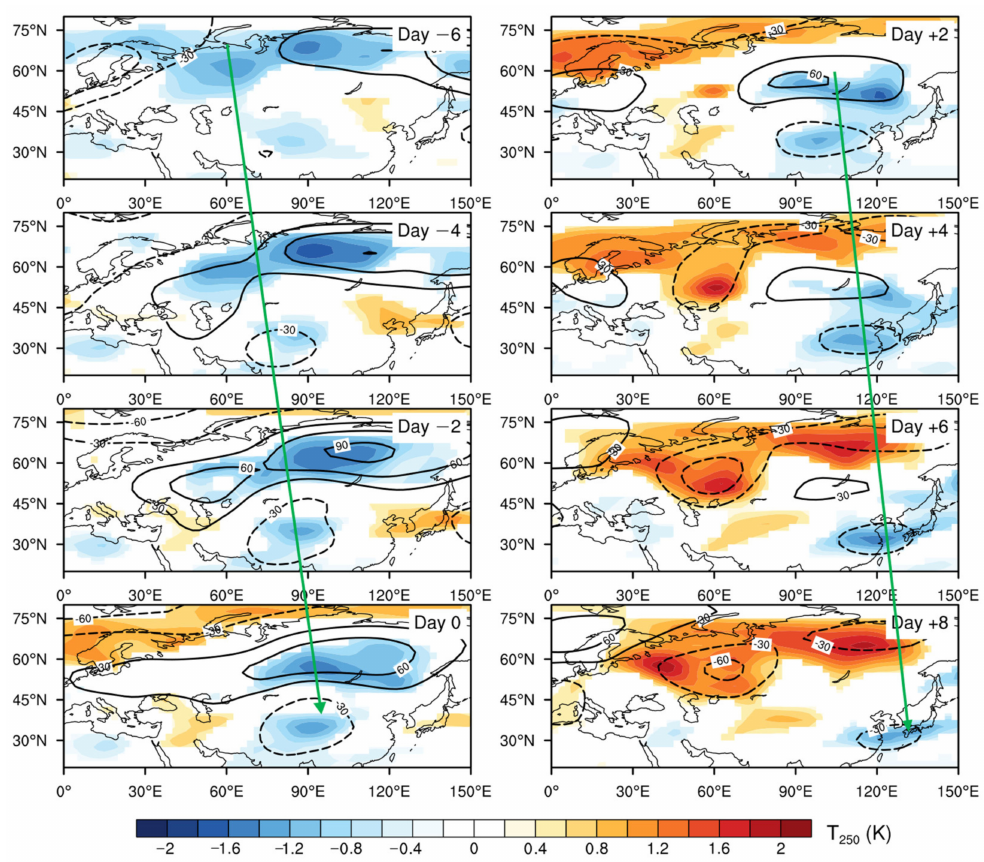
Figure 5. The regressed horizontal spatial distribution of 10–60-day filtered geopotential height anomalies at 250 hPa (contours; unit: gpm) and temperature anomalies at 250 hPa (shadings; unit: K) on PC1 of 2018 wintertime. Contour interval for the geopotential height anomalies is 30 gpm. Only the fields exceeding the 0.05 significant level based on a two-tailed Student’s t -test are shown. The green arrow represents the southeastward movement of negative temperature anomaly center at 250 hPa from Day − 6 to Day